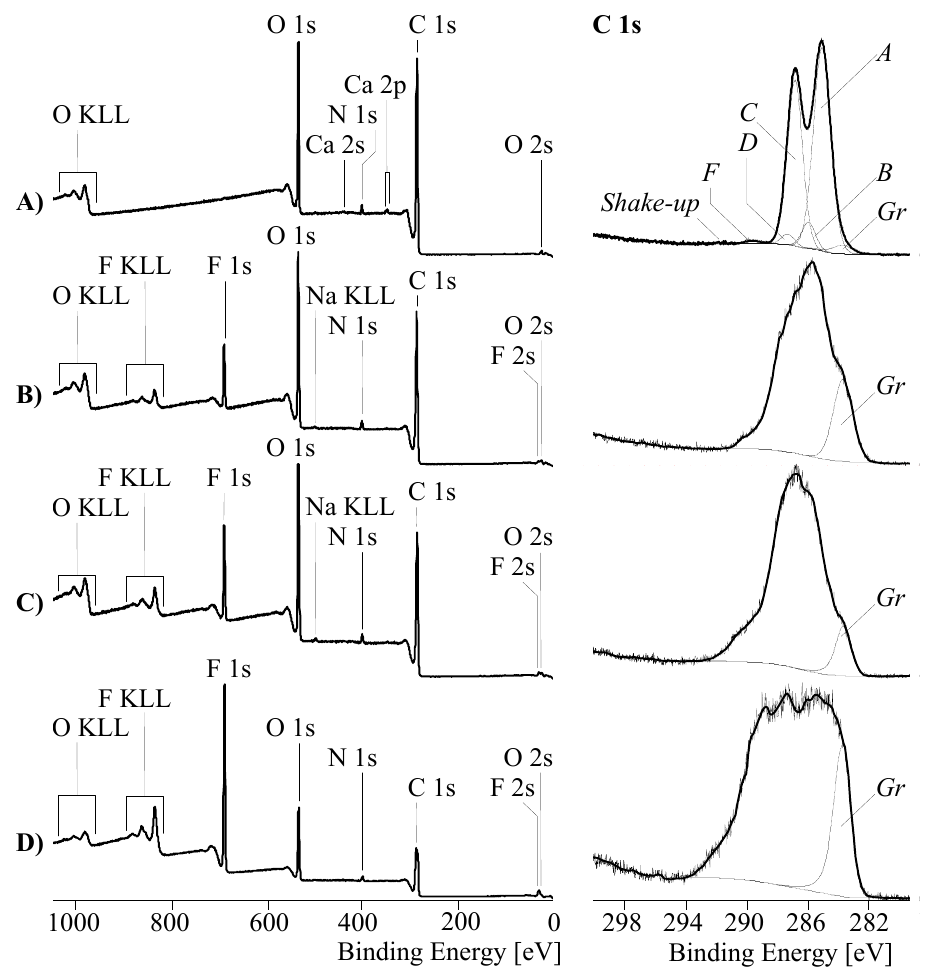
Figure 7. Wide scan (left column) and high-resolution C 1s (right column) XPS spectra recorded from an untreated PAN-based carbon fiber sample (I-CF00/000–A) and carbon fiber samples, which were oxy-fluorinated with 1 vol% (I-CF01/180–B), 5 vol% (I-CF03/180–C), and 10 vol% (I-CF10/180–D) fluorine in the process